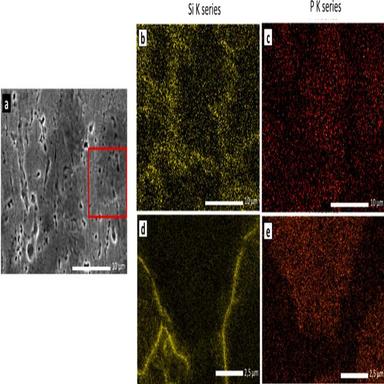
The SEM image of the surface after PCC (a), the corresponding EDX maps of Si and P (b,c), and the EDX maps of Si and P in the red square (d,e).